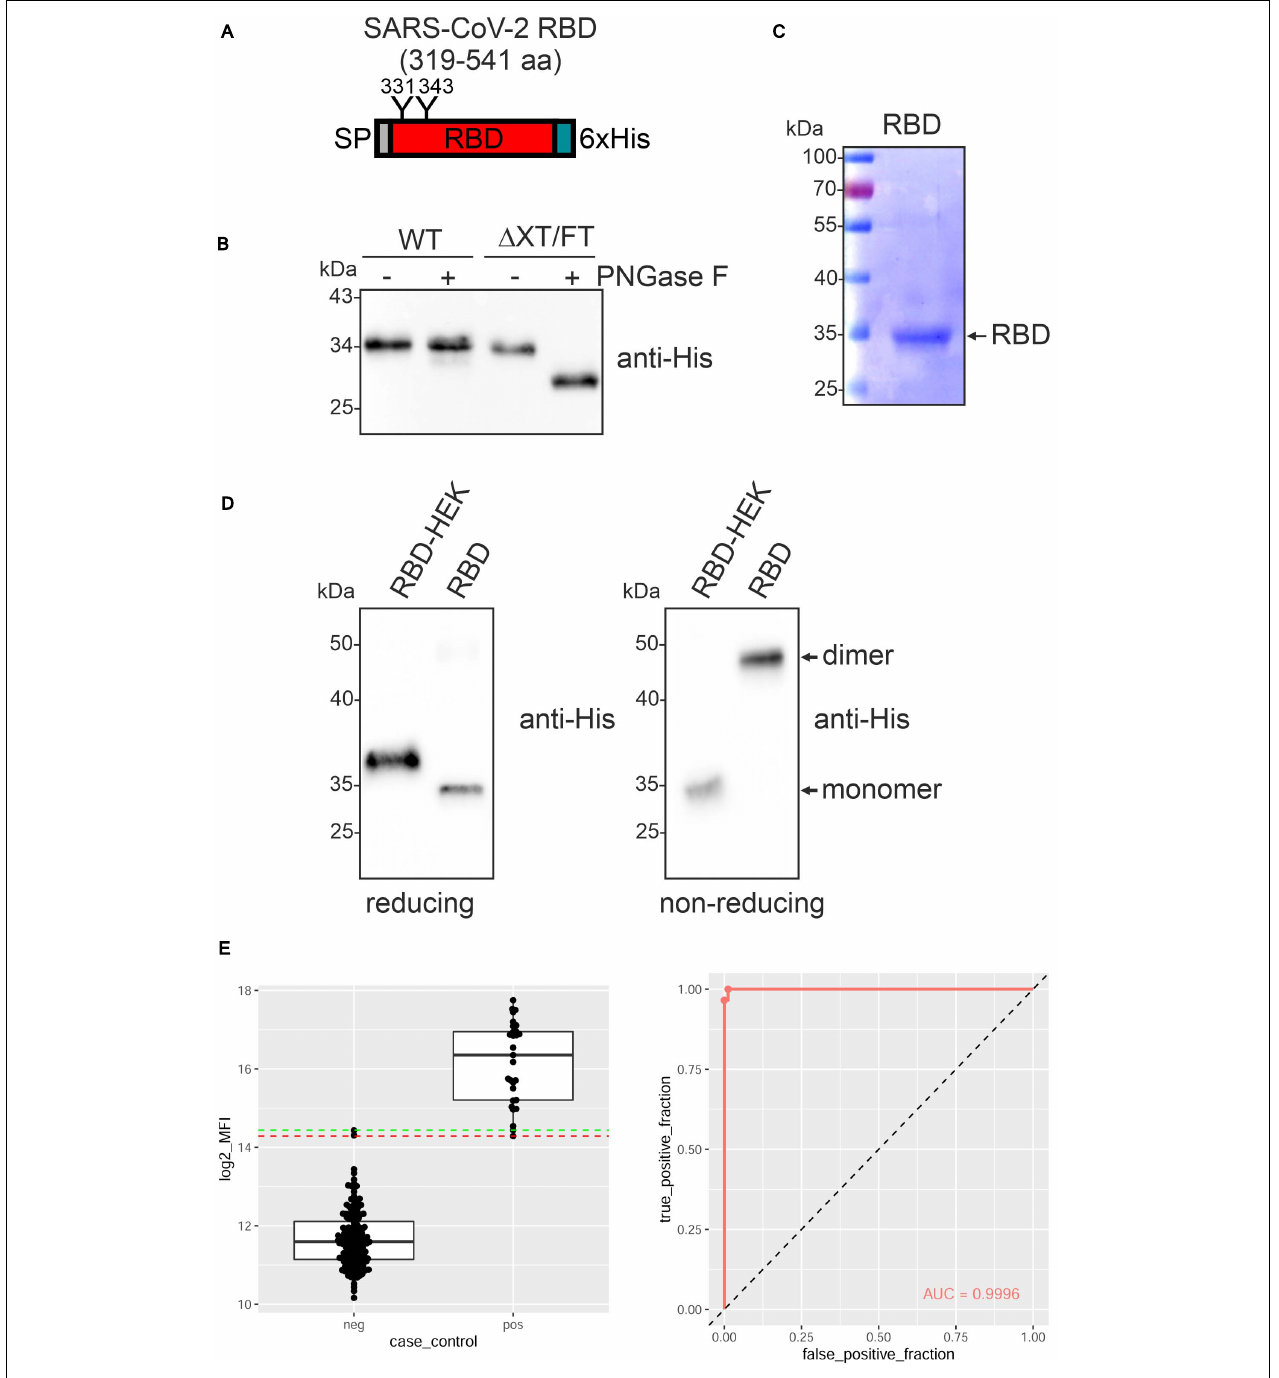
FIGURE 1 | SARS-CoV-2 RBD is poorly expressed in Nicotiana benthamiana . (A) Schematic illustration of the SARS-CoV-2 RBD variant that was expressed. The position of the signal peptide (SP), the two N-glycans at position N331 and N343 and the C-terminal 6x histidine tag are indicated. (B) Protein extracts from infiltrated N. benthamiana wild-type (WT) or (cid:49) XT/FT plants were subjected to PNGase F digestion and analyzed by immunoblots with antibodies against the 6x histidine-tag. (C) RBD produced in (cid:49) XT/FT was purified from the apoplastic fluid 4 days after infiltration, subjected to SDS-PAGE under reducing conditions and stained with Coomassie Brilliant Blue. (D) Immunoblot analysis of RBD produced in HEK293 cells (RBD-HEK, 319–541 aa) and RBD produced in N. benthamiana . SDS-PAGE was carried out under reducing and non-reducing conditions. (E) Binding of sera from blood donors collected prior to 2018 (neg, n = 163) and sera from SARS-CoV-2 exposed individuals (pos, n = 26) to plant-produced RBD. Binding was analyzed using a Luminex bead-based assay and the median fluorescent intensity (log2 MFI) is shown. The lines indicating the 100% sensitivity cut-off (red) and the 100% specificity cut-off (green) as well as the receiver operating characteristic (ROC) curve and the area under the curve (AUC) are